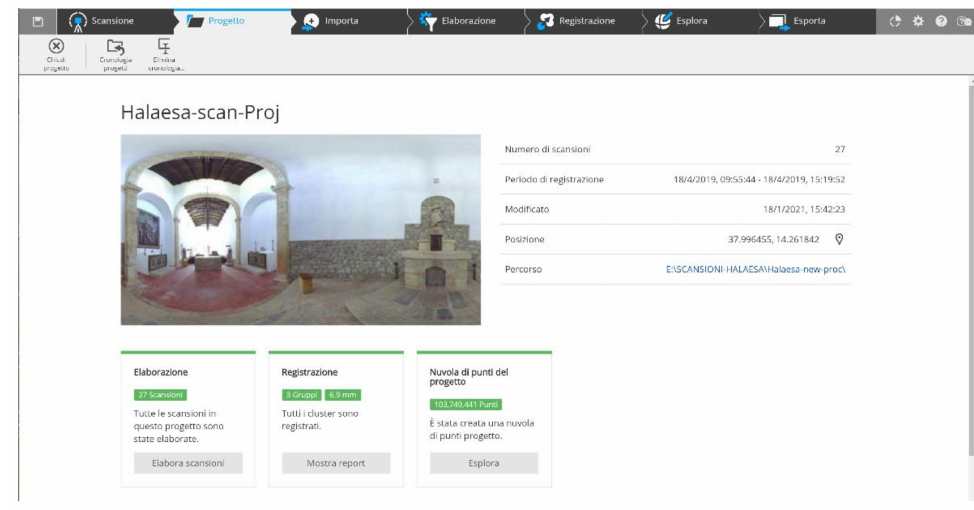
Figure 7. Survey project overview on Faro Scene: the program display information about the number of scans processed, the number of clusters and the total number of points of the